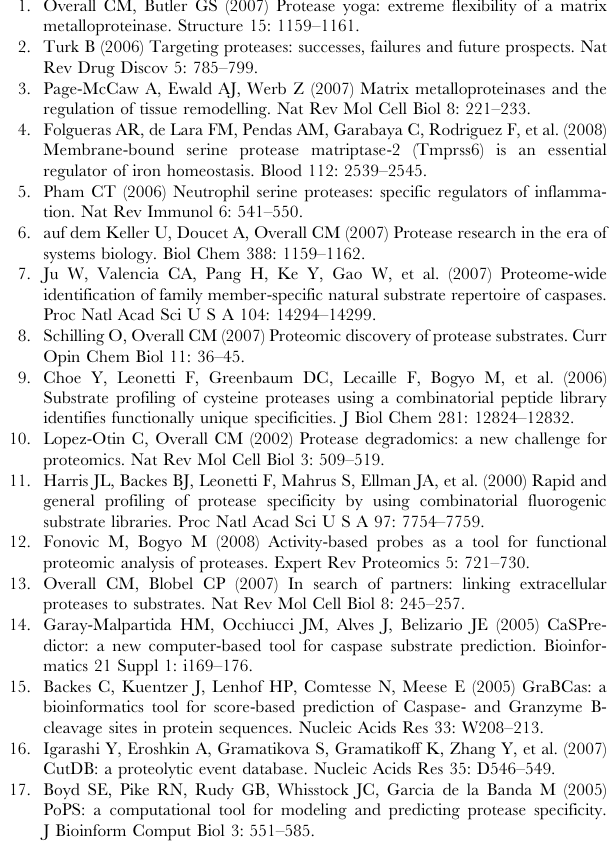
Table S5 Relative Solvent Accessibility (rSASA) Values of Natural Substrates of Proteases